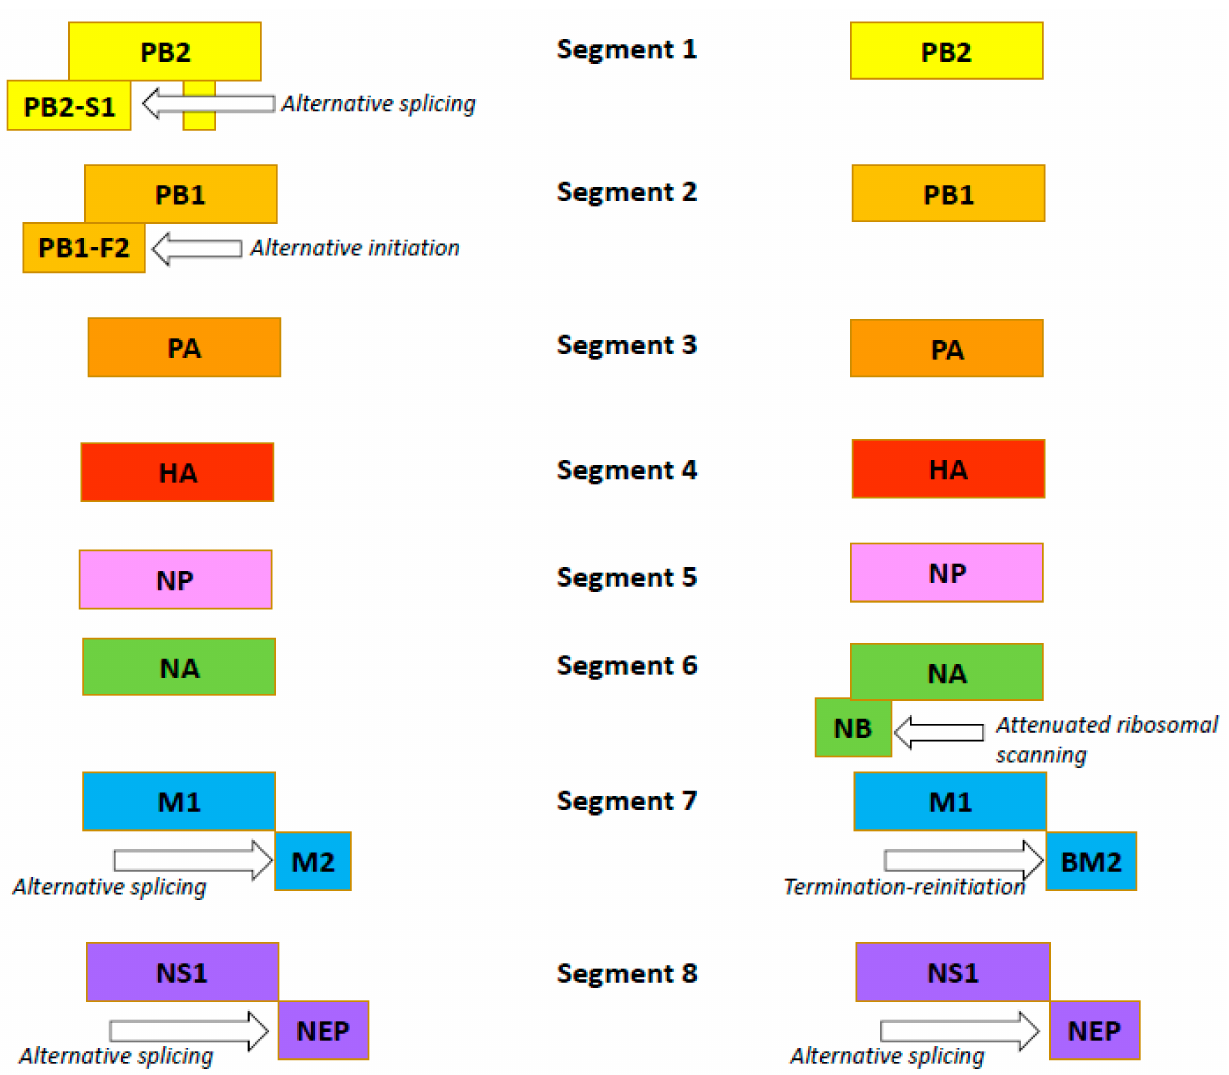
Figure 2. Organization of the influenza A (the left side) and B (the right side) viruses’ genomes. Hemagglutinin is the main influenza virus surface glycoprotein. It is responsible for viral attachment and host cell entry via interaction with sialic acid. The functional HA unit is a homotrimer, with each monomer comprised of two domains, HA1 and HA2, linked by a disulfide bond. HA2 forms the membrane anchor and the long alpha-helix ‘stem’ or ‘stalk’, and HA1 forms the distal globular head that contains the receptor binding site (RBS) and the majority of the antigenic sites [70]. The head domain of HA contains four immunodominant, highly variable antigenic sites: the 120 loop; the 150 loop; the 160 loop; and the 190 helix. These are the main targets of neutralizing antibodies and are subject to antigenic drift. Neutralizing antibodies prevent infection by blocking interaction between the RBS (in the head of HA) and sialic acid receptors (on host cells). The blocking of HA attachment to the cell occurs through the interaction between the antibody’s Fab fragment and the HA